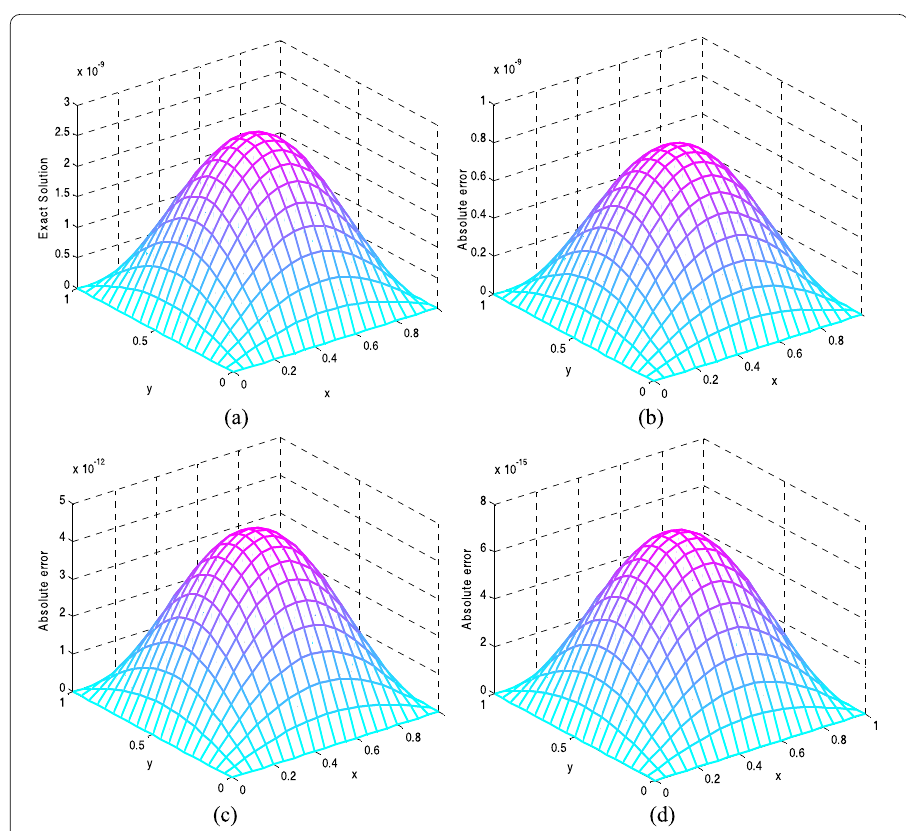
Figure 1 The exact solution ( a ), the absolute error obtained from P–R scheme ( b ), present fourth order scheme ( c ), and present sixth order scheme ( d ), with h = τ = 1/20 at T = 1, Problem 1